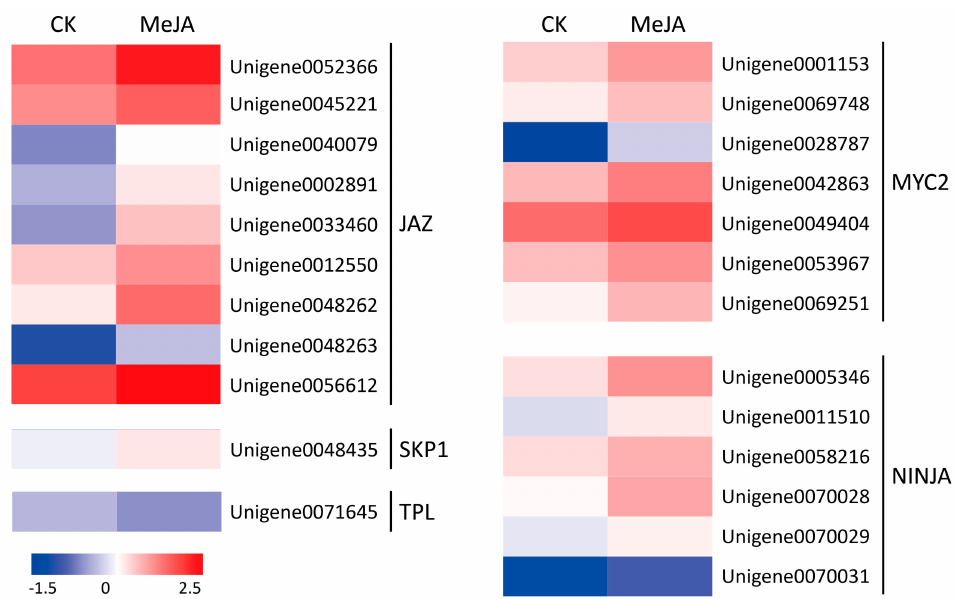
Figure 3. Heat maps of the DEGs in JA signal transduction pathway. JAZ, Jasmonate ZIM domain protein; MYC2, bHLHzip transcription factor MYC2; TPL, TOPLESS; NINJA, Novel interactor of JAZ; SKP1, S-phase kinase-associated protein 1.